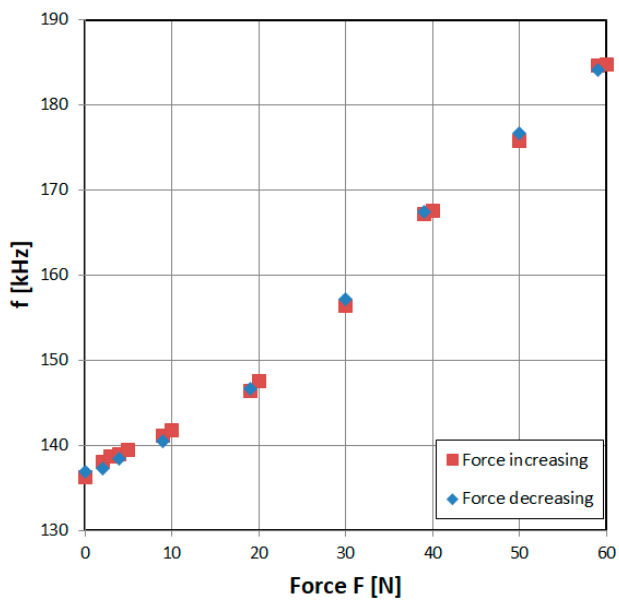
Figure 10. Exemplary results of magnetoelastic sensor with 555 transducer output characteristic.